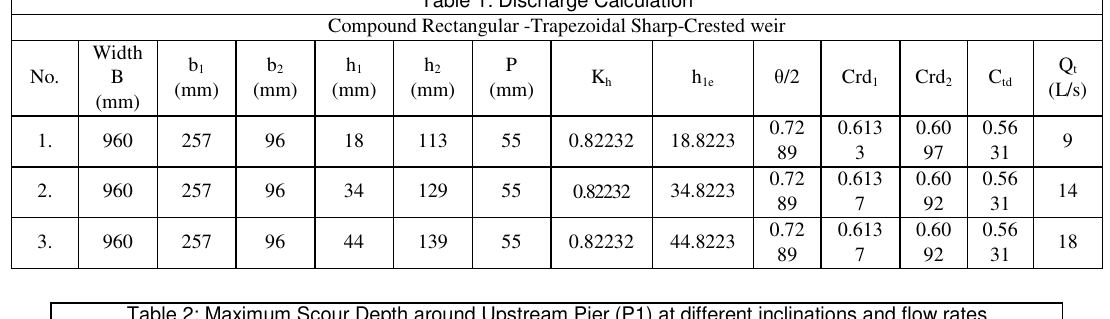
Table 2: Maximum Scour Depth around Upstream Pier (P1) at different inclinations and flow rates Upstream